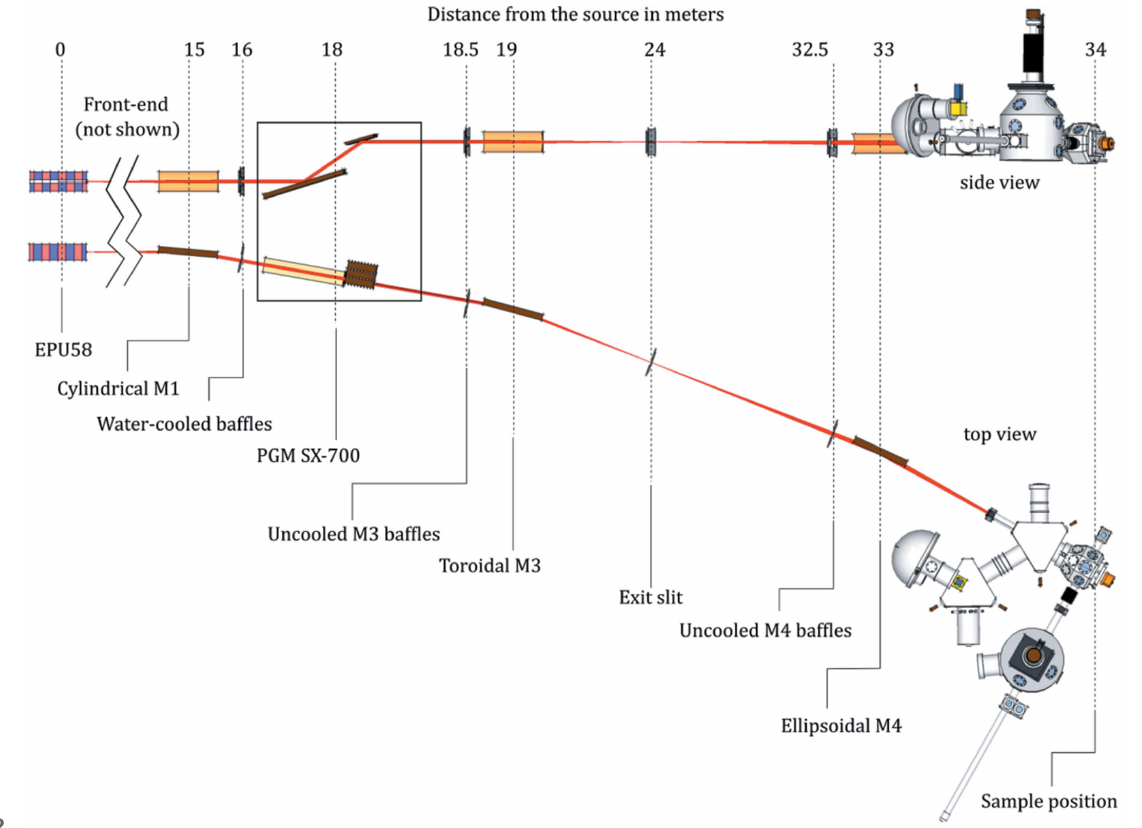
Figure 2 Optical layout of the MAXPEEM beamline with a single refocusing ellipsoidal mirror (M4). Distances are given in metres (not to